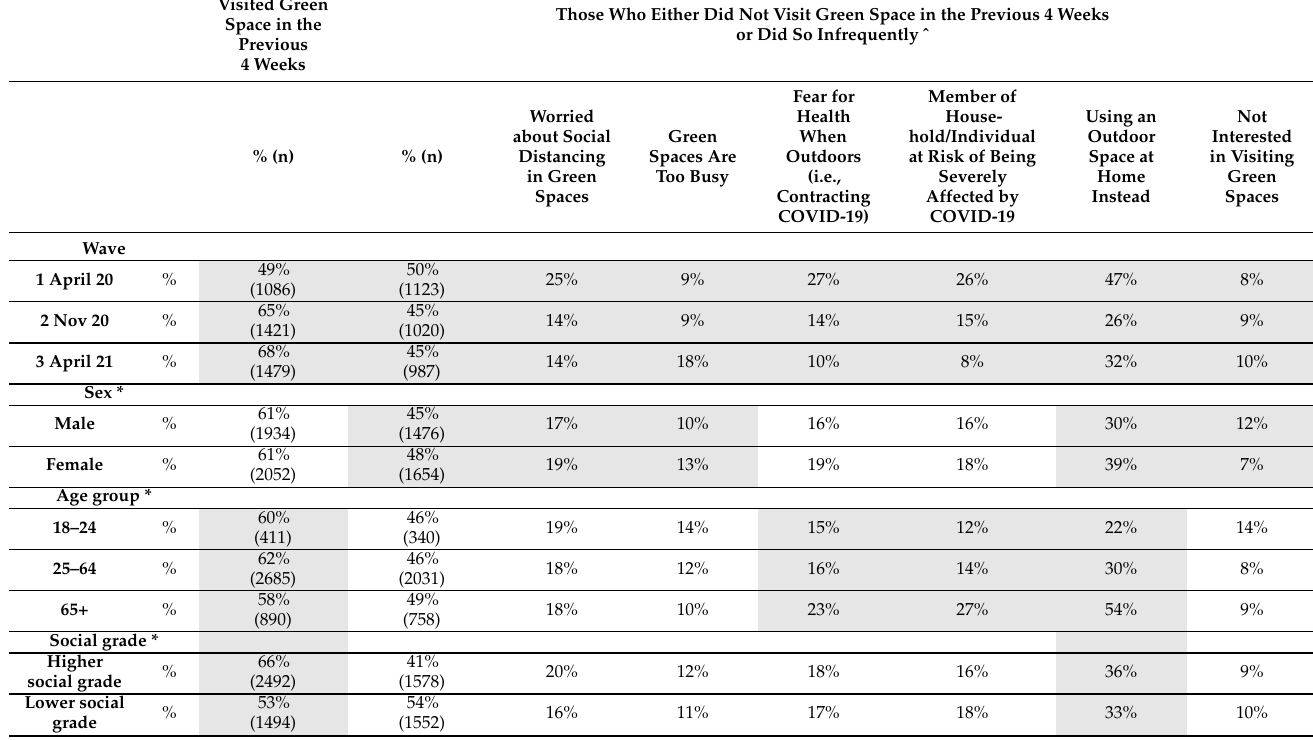
Table 2. Proportions visiting green spaces or reporting barriers to doing